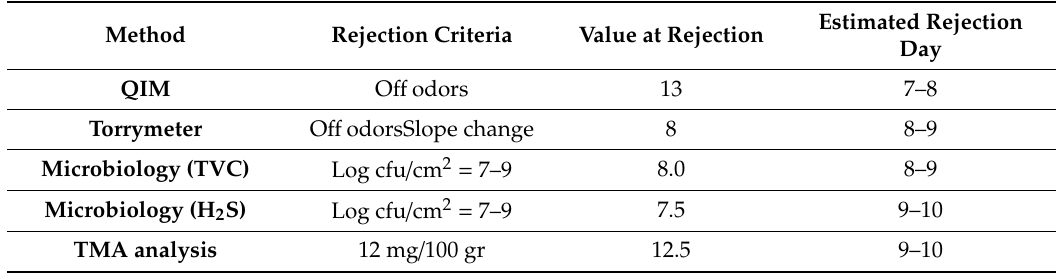
Table 4. Estimated rejection day for di ff erent assayed methods.